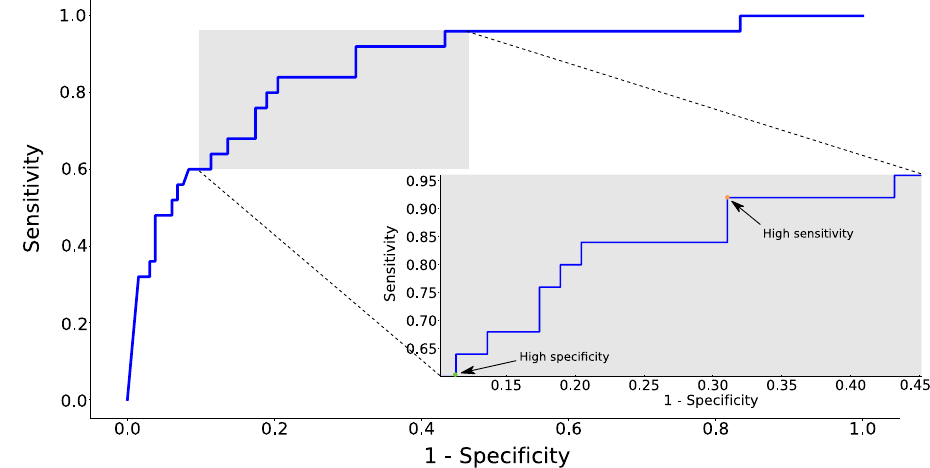
Figure 2. ROC curve obtained by using an ensemble of 10 models trained on the SData set ( n = 22 ), to infer PD on the GData set ( n = 157 ). The corresponding AUC is 0.868 with a 95% confidence interval of 0.773–0.948. Figure was drawn using Inkscape v1.0 https ://inksc ape.org/.